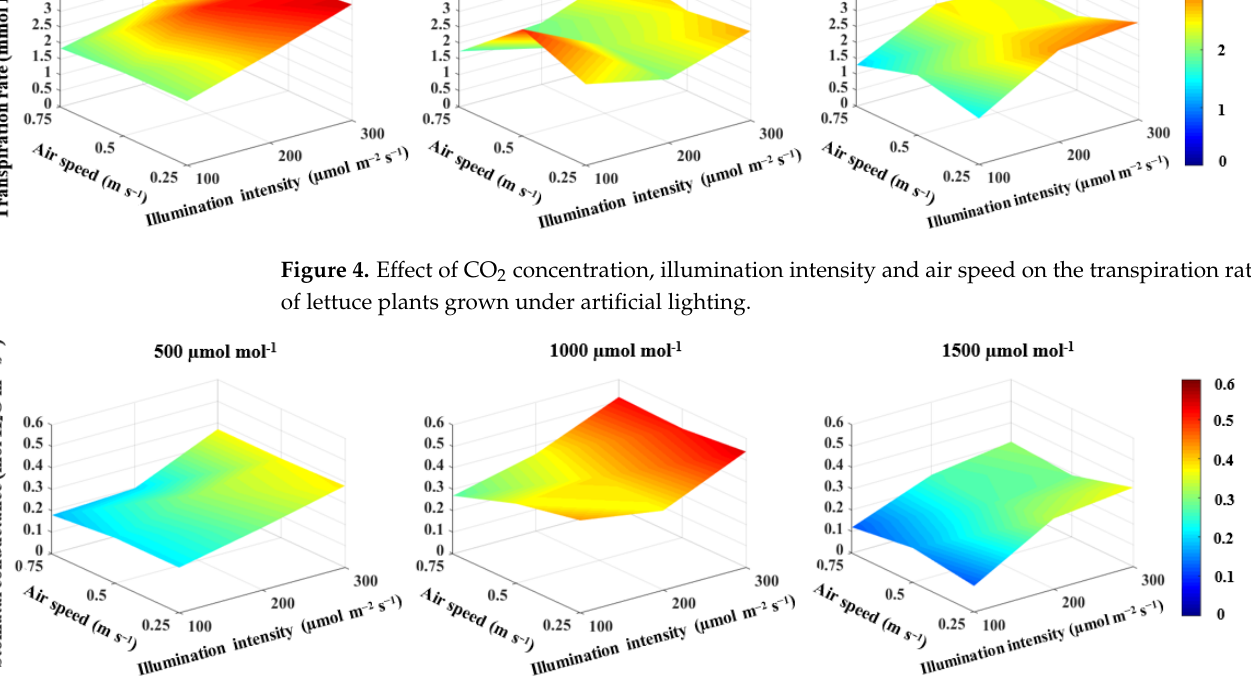
Figure 5. Effect of CO 2 concentration, illumination intensity and air speed on the stomatal conduc- tance of lettuce plants grown under artificial lighting.